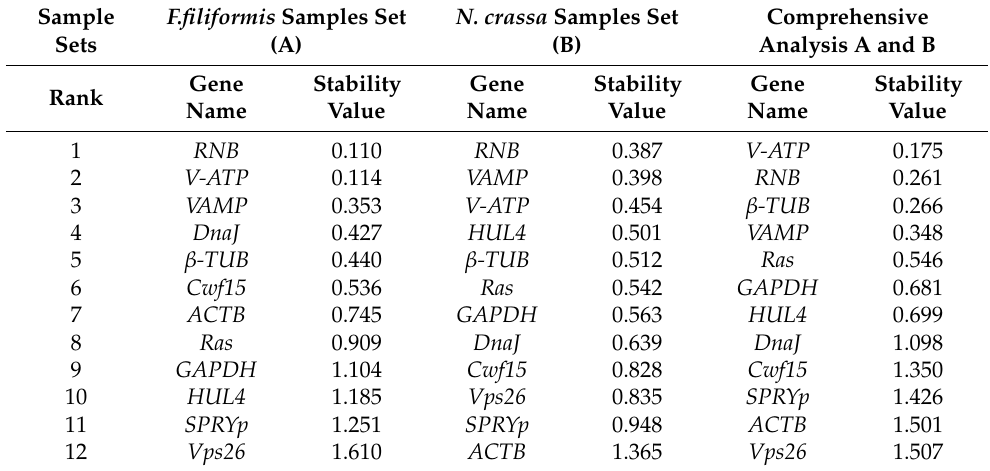
Table 4. The stability analysis of 12 ICGs candidates using NormFinder in F. filiformis and N. crassa . F.filiformis Samples Set N. crassa Samples Set Sample Sets (A)